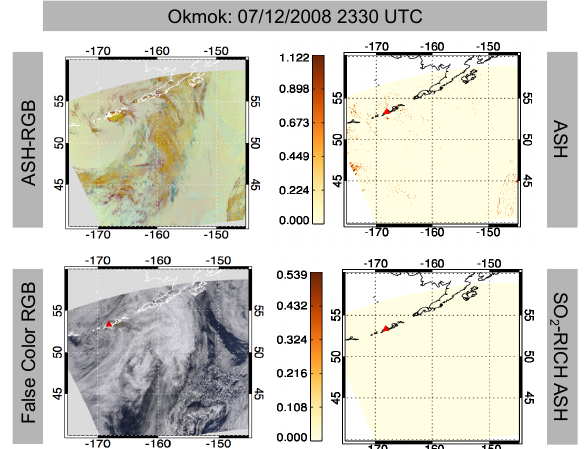
Figure 3. (Top left) Ash-RGB created using MODIS infrared bands 32–31, 31–29, and 31 for the eruption of Kelut, 14 February, 0335Z; (bottom left) false color RGB created using MODIS reflective bands 1, 4, and 3 for the same eruption and time; (top right) ash-detection neural network output for the same eruption and time; (bottom right) SO 2 -rich-ash-detection neural network output for the same eruption and time.